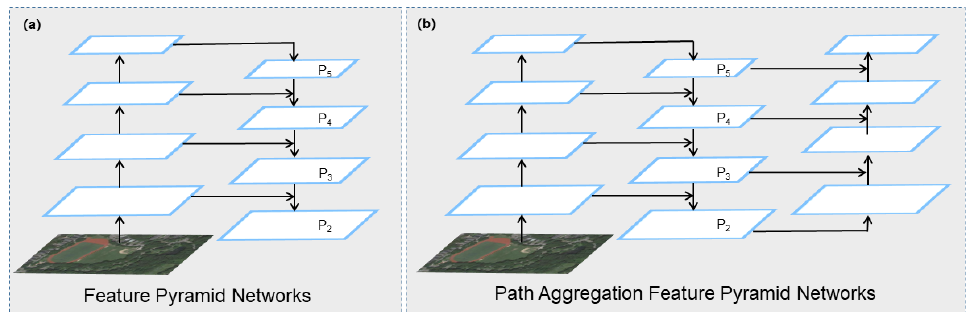
Figure 1. ( a ) Structure diagram of FPN and ( b ) Structure diagram of PAFPN. Comparing the two, PAFPN has one more bottom-up path than